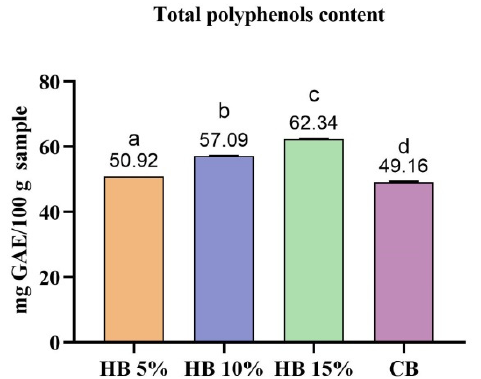
Figure 5. Content of total polyphenols in the studied samples. Mean values are expressed as mg gallic acid equivalent GAE/g sample. The error bars indicate standard deviation. Different letters among samples indicate significant differences ( p < 0.05) among values according to the t-test.